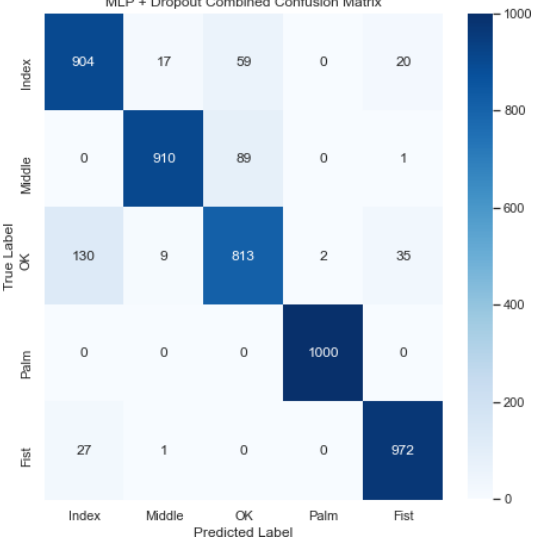
Figure 10. Combined confusion matrix for MLP model. Rows represent actual classes; columns represent predicted classes. Dark blue shading indicates a large value; light blue shading indicates a small value. The average accuracy, precision, recall, and F 1 score for this model were 96.87%, 92.25%, 92.16%, and 92.16%, respectively.